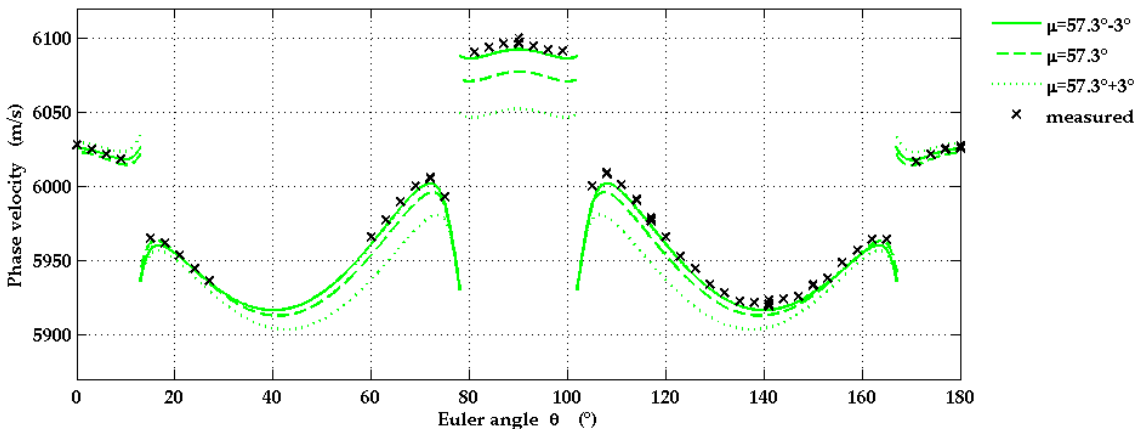
Figure 7. Experimental values of the SAW phase velocities for various propagation directions on r- plane sapphire (black crosses) and corresponding calculated curves, taking into account off-cut an- gles χ = ±3°. Here the elastic constants from [30] were used for calculations.